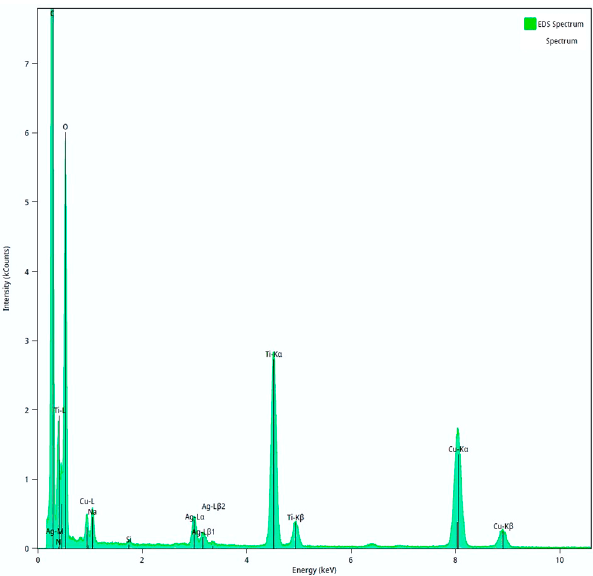
Figure 11. Energy-dispersive spectroscopy (EDS) analysis of Ag-TiO 2 /microgel composite.